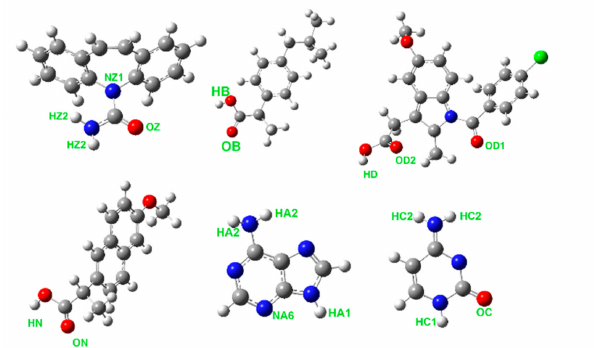
Figure 1. Molecular structures of carbamazepine ( top left ), ibuprofen ( top center ), and indomethacin, ( top right ) and naproxen ( bottom left ), adenine ( bottom center ), and cytosine ( bottom right ). Atom types contributing to the hydrogen bonding most strongly are marked for each